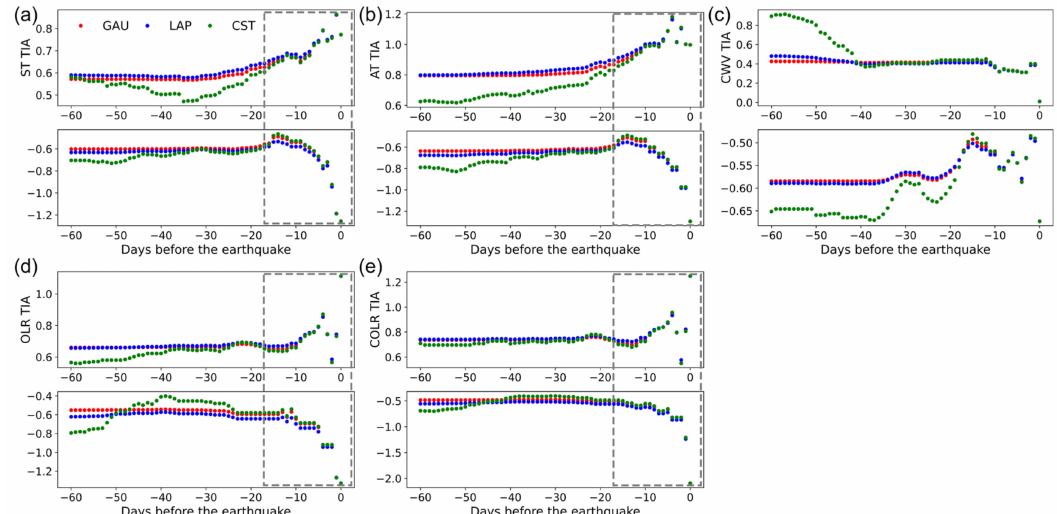
Figure 5. Trend characteristics for multiparametric temporal integrated anomalies (TIAs) before the 2013 M7.7 Awaran earthquake, Pakistan, demonstrating simultaneously enhanced positive & negative TIAs close to earthquake occurrence. ( a ) Skin temperature (ST) TIA; ( b ) air temperature (AT) TIA; ( c ) total integrated column water vapor burden (CWV) TIA; ( d ) outgoing longwave radiation (OLR) TIA; ( e ) clear-sky OLR (COLR) TIA. The two subfigures for each anomaly show the positive and negative TIAs, respectively. Negative days at the abscissa denote the days before the earthquake. The gray dashed frame indicates the TIA trend characteristics. The red, blue, and green dots denote Gaussian (GAU), Laplace (LAP), and Constant (CST) weight integration functions, respectively.